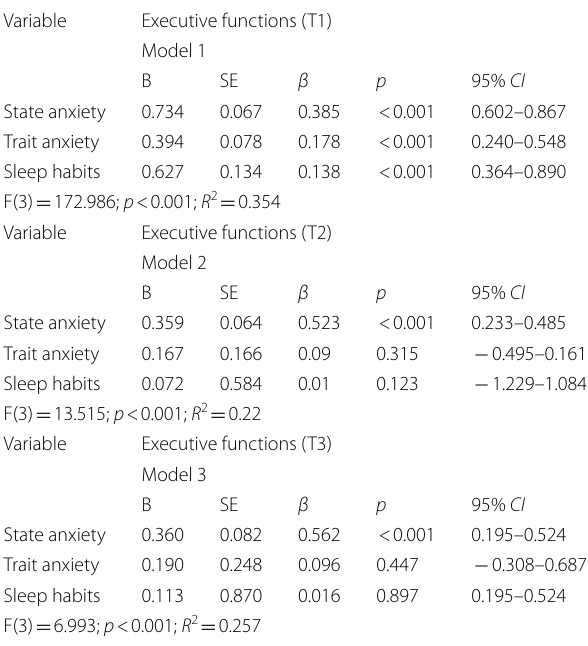
Table 4 Regression analysis of trait/state anxiety and sleep habit variables as predictors of executive functions for T1, T2 and T3